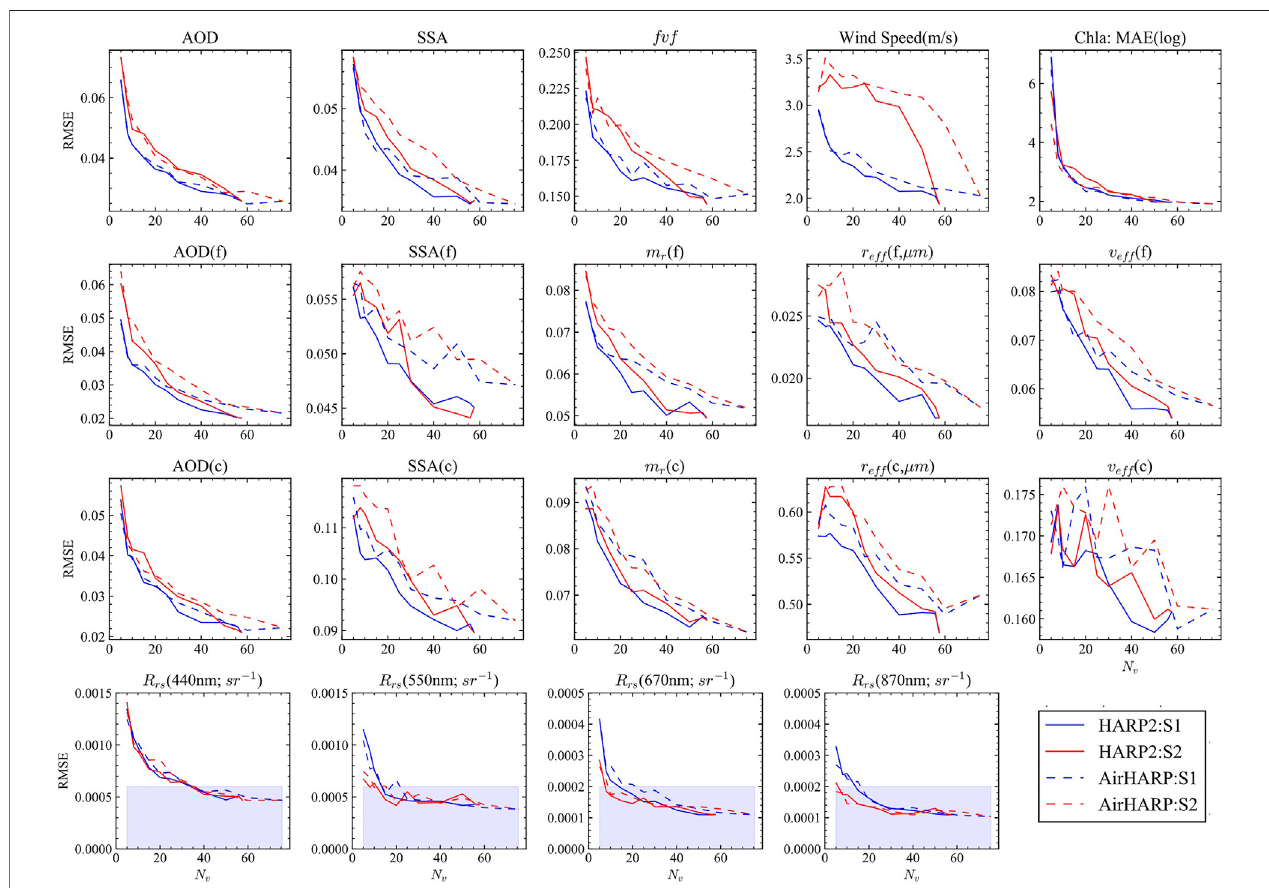
FIGURE 5 | Retrieval errors in terms of root mean square error (RMSE) from the retrieval of 1,000 cases for AirHARP and HARP2, and with the two schemes of angle screening as shown in Figure 3 . AOD and SSA RMSE are for the wavelength of 550 nm. Note that the retrieval errors for Chla is represented by the MAE error of Chlain logscale as used in Gaoet al.(2021), which is different from other quantities. R rs RMSE at all the four wavelengthswithAOD (550 nm) < 0 . 2 areshown in thelast row with shaded area indicating the PACE mission R rs uncertainty goal. The horizontal axis, N v , is the total number of angles used in the retrievals, which is equivalent to the total number of unique measurements of 2 N v including both re fl ectance and DoLP across four HARP bands as discussed in Section 3.1 .